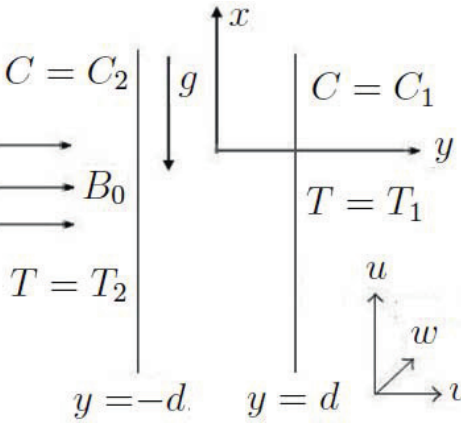
Fig. 1: Physical model and coordinate